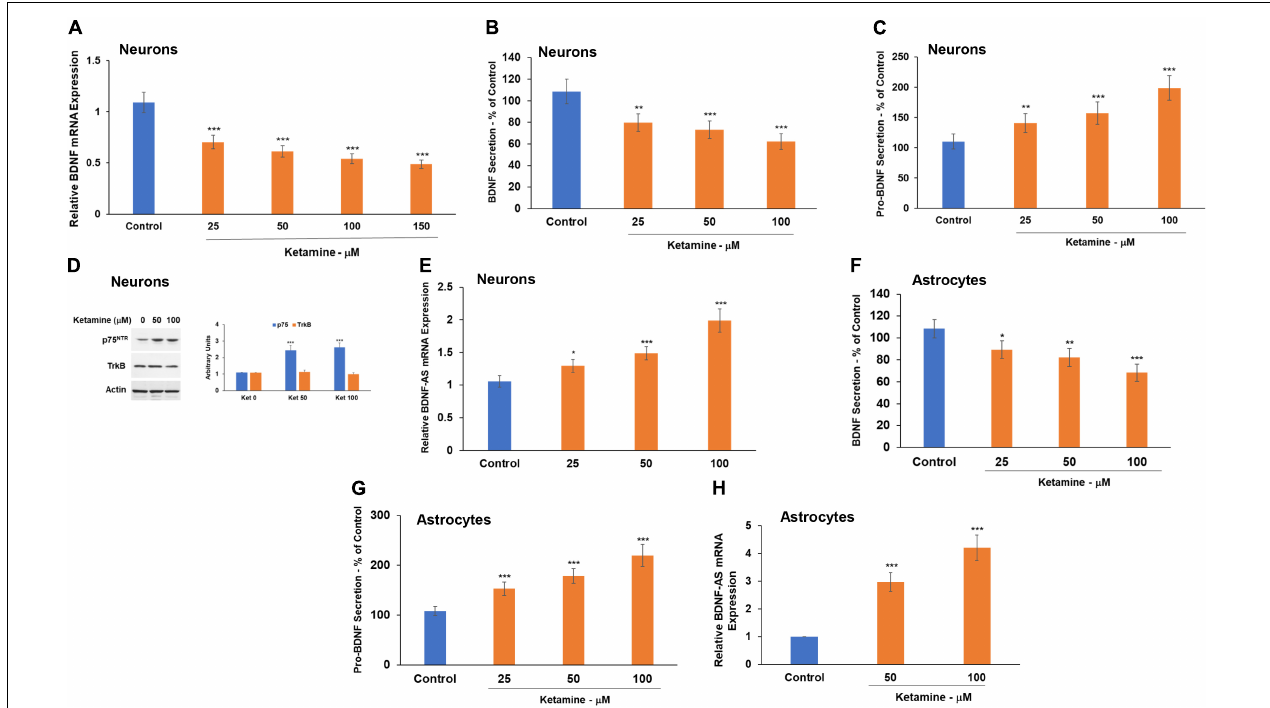
FIGURE 4 | Ketamine regulates the BDNF pathway in neurons and astrocytes. Human neurons were treated with ketamine and the expression of BDNF mRNA was determined using RT-PCR (A) and BDNF secretion by ELISA (B). Pro-BDNF secretion was analyzed using ELISA (C) and the expression of p75 NTR and TrkB was analyzed using Western blot analysis (D). The effect of ketamine on BDNF (F) and pro-BDNF (G) secretion in astrocytes was analyzed using ELISA. The expression of the lncRNA BDNF-AS was analyzed using RT-PCR in both neurons (E) and astrocytes (H). The results are the means ± SD of three independent experiments analyzed in quadruplets or are a representative of three independent experiments (D) . * P < 0.05, ** P < 0.01, and *** P <